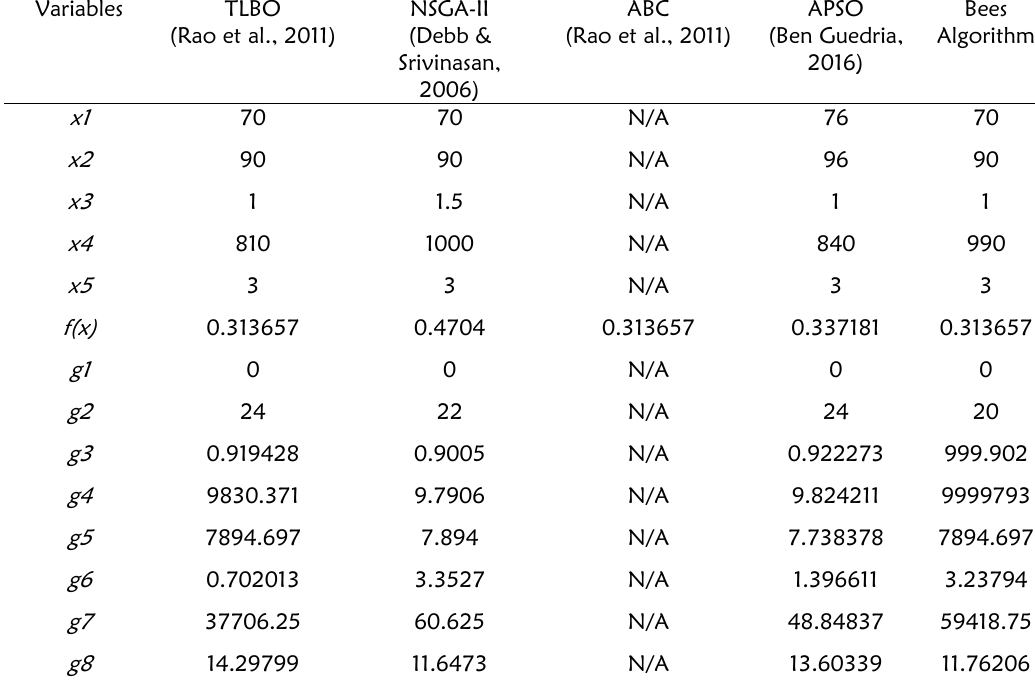
Table 3: Values of Objectives Functions, Design Variables and